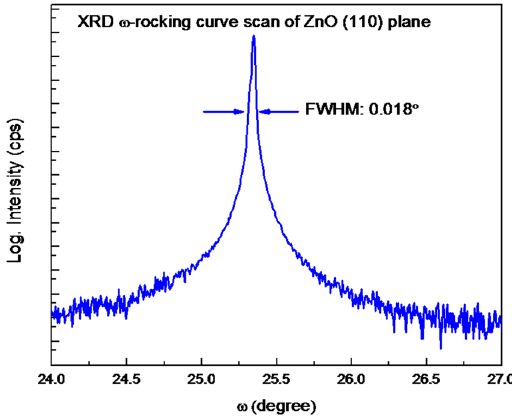
Figure 1. X-ray rocking curve (XRC) of the ZnO single